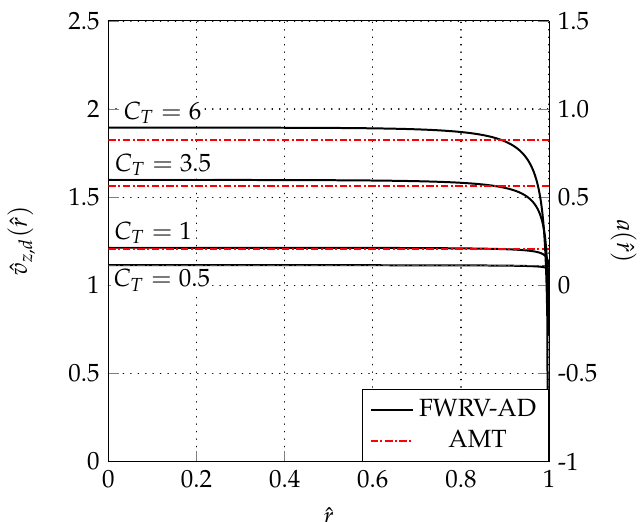
Figure 9. Comparison between the axial velocity at the disk evaluated through the free-wake ring-vortex method and the AMT.